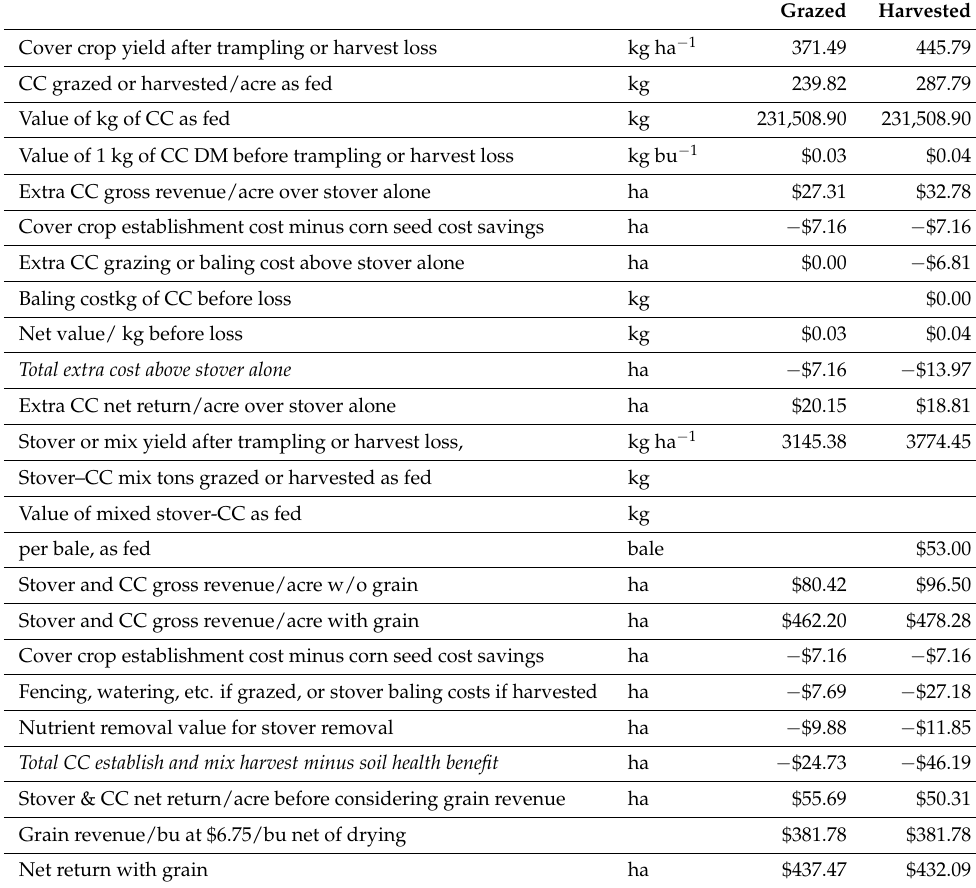
Table 5. Revenue, costs, and net return of establishing and harvesting a stover–CC mix in the 152-cm corn